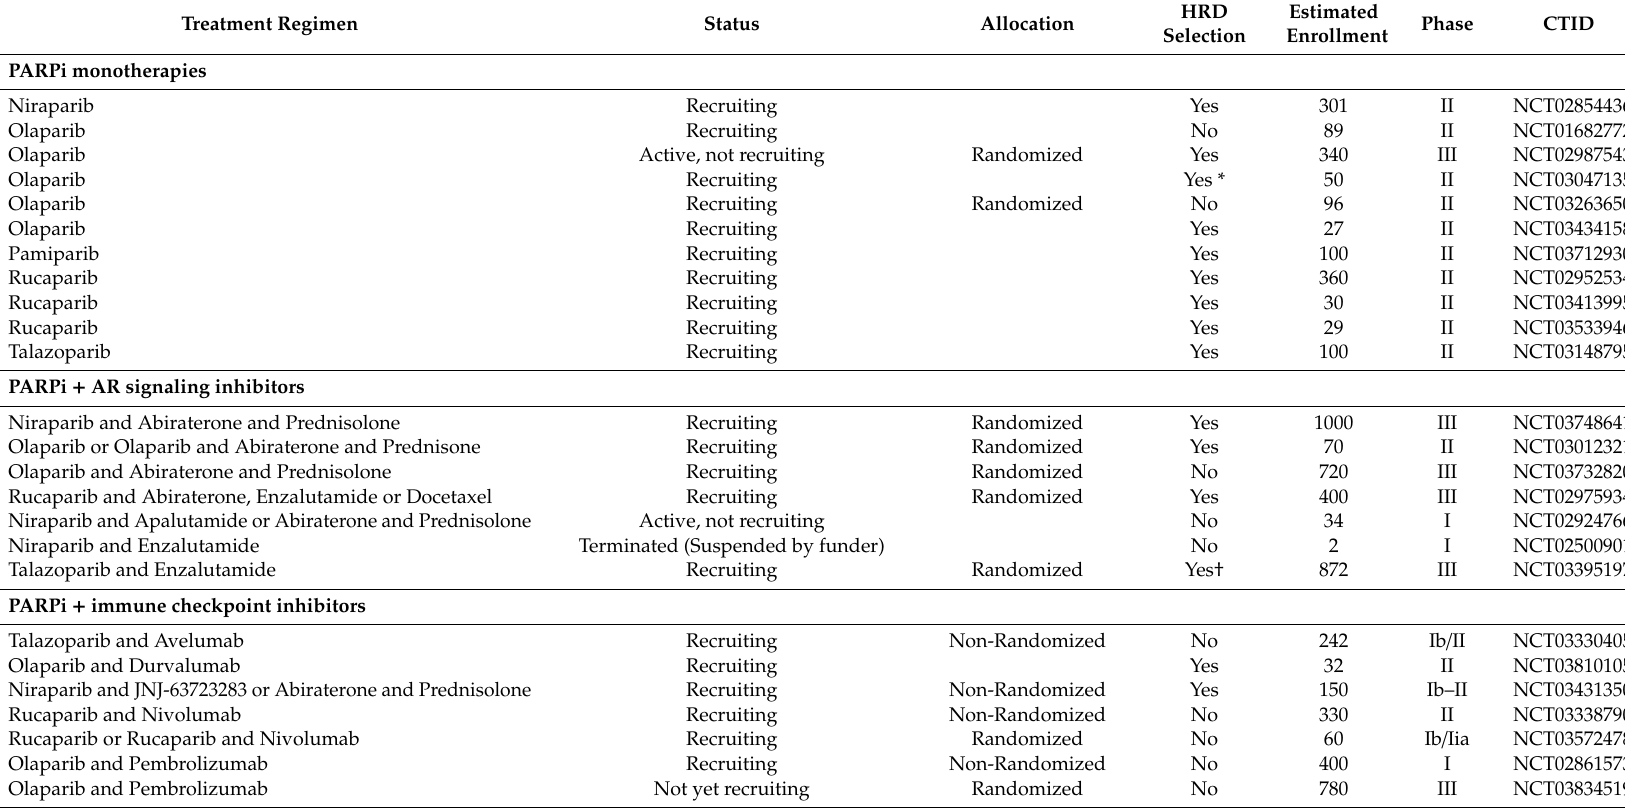
Table 3. Ongoing clinical trials using PARP inhibitors to treat prostate